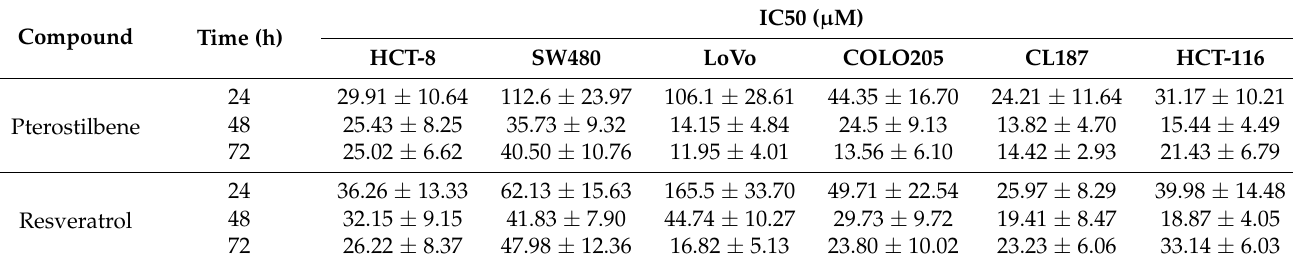
Table 1. The IC50 values of PTE and RE in colorectal cells. Data are mean ± SD, n =